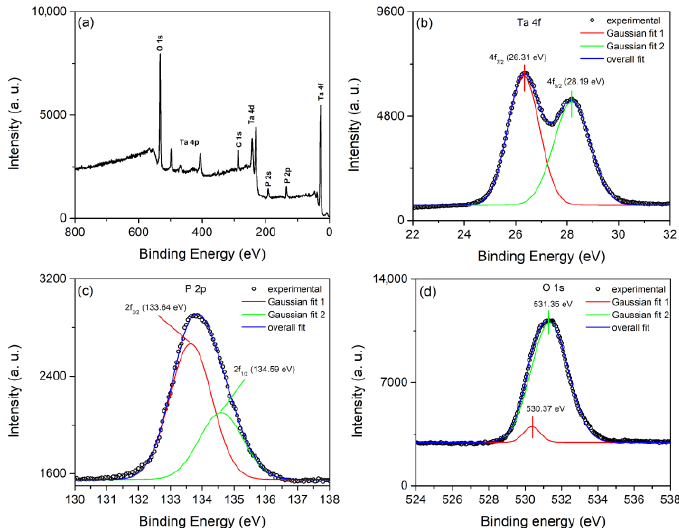
Figure 6. ( a ) Survey XPS spectrum of coating formed for 900 s. High resolution XPS spectra: ( b ) Ta 4f; ( c ) P 2p; ( d ) O 1s. The photocatalytic performance of Ta 2 O 5 coatings was tested in MO degradation. Three samples were tested for each processing time, with the mean values shown in Figure 7a. The PA of samples obtained under the same conditions is highly reproducible (within 3%). Co represents the initial concentration of MO, whereas C rep- resents the concentration after time t . The coating with the highest photocatalytic effi- ciency was formed for 15 min. Ta 2 O 5 coatings have a much higher efficiency in MO degradation than TiO 2 [49], MgO [50], MgAl [38], ZrO 2 [51], and Nb 2 O 5 [52] coatings respectively (Figure 7b).